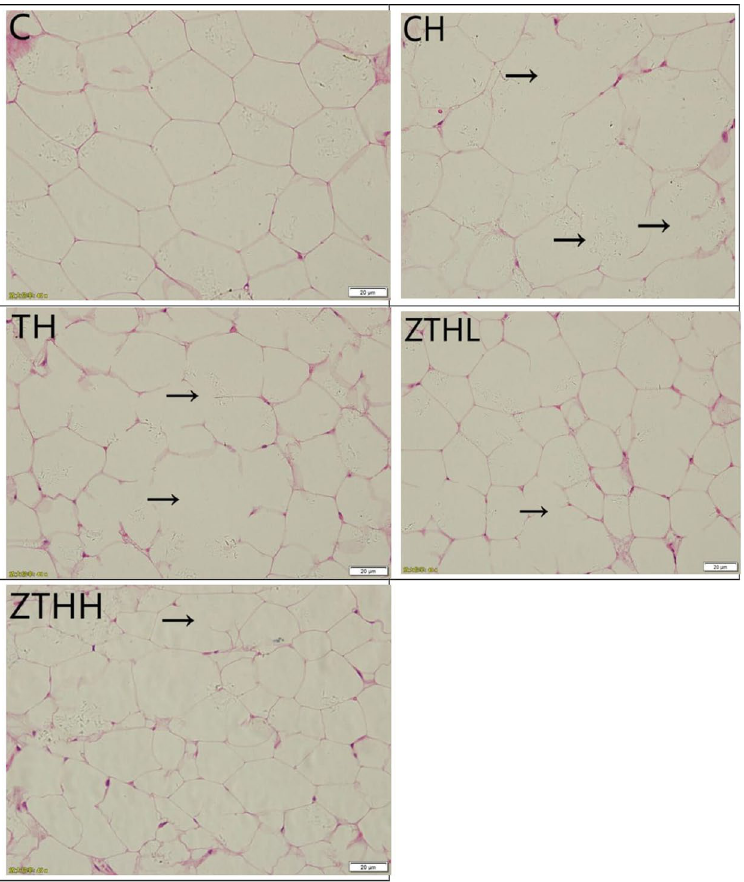
Figure 10. The histological features of adipose tissue in experimental rats (400 × ). Fat tissue of SD rats was stained with hematoxylin and eosin. Arrow: adipocyte incorporation.